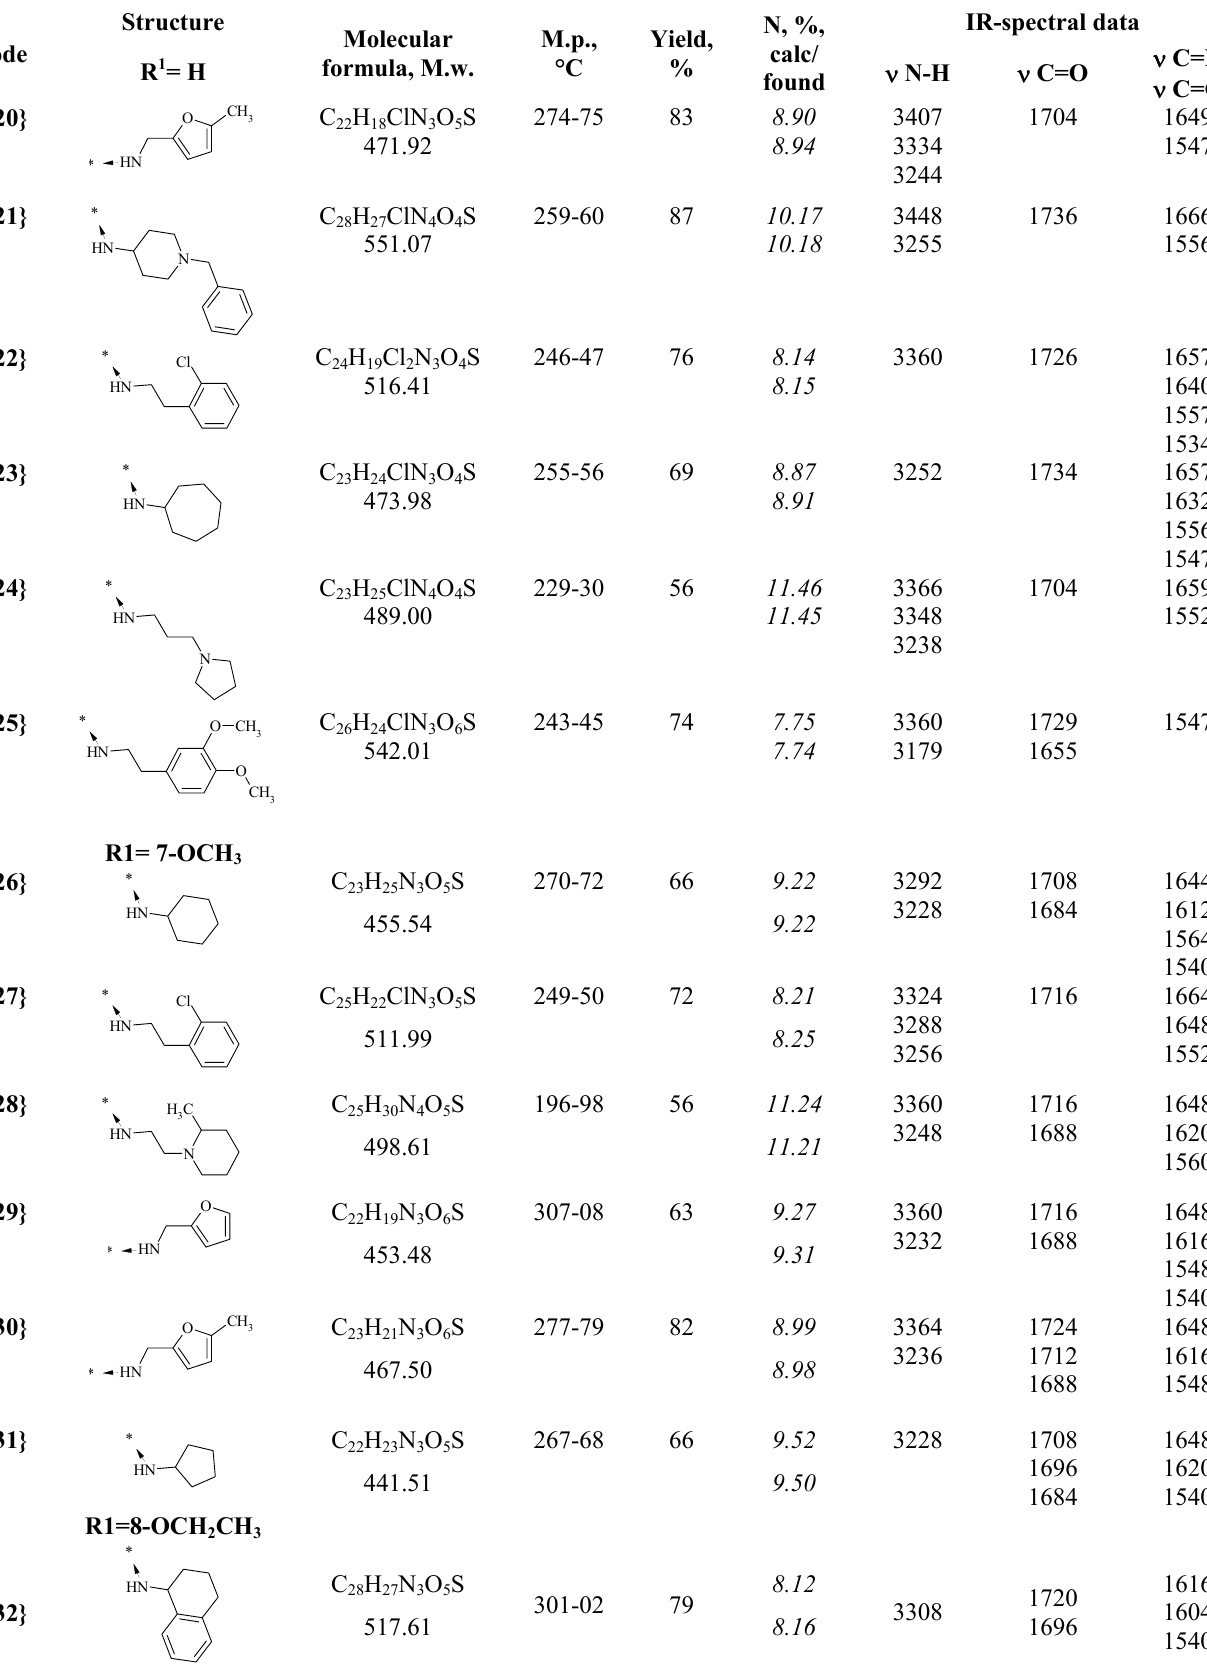
Structure IR-spectral